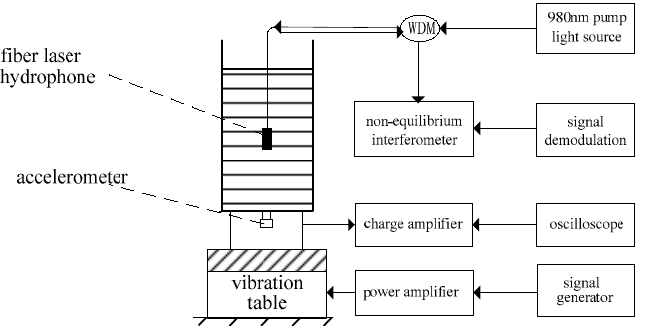
Figure 7. Calibration of FLH by vibrating liquid column method.